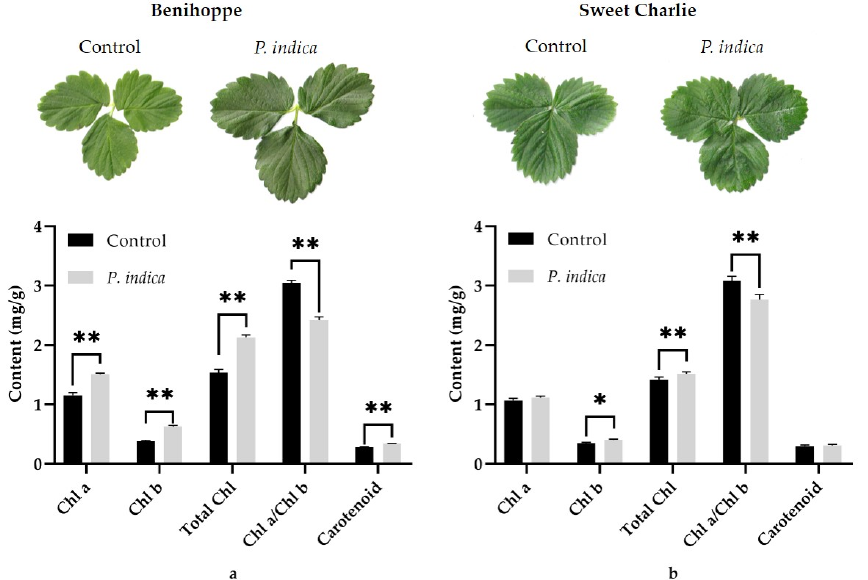
Figure 3. The influences of P. indica on the leaf color and photosynthetic pigments content in straw- berry leaves. ( a ) The photosynthetic pigments content in leaves of strawberry variety ‘Benihoppe;’ ( b ) The photosynthetic pigment contents in leaves of strawberry variety ‘Sweet Charlie.’ Values were presented as mean ± SD (standard deviation) of three replications. *, p < 0.05; **, p < 0.01.